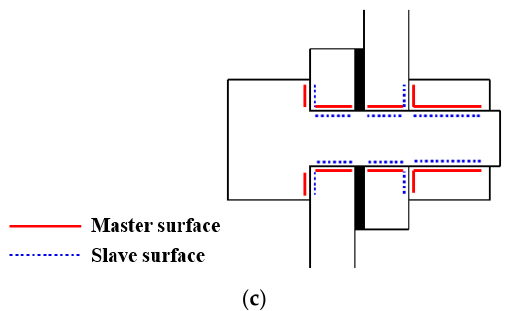
Figure 5. ( a ) Parts and constraints; ( b ) mesh generation and boundary conditions; ( c ) master and slave surfaces in each contact pair.